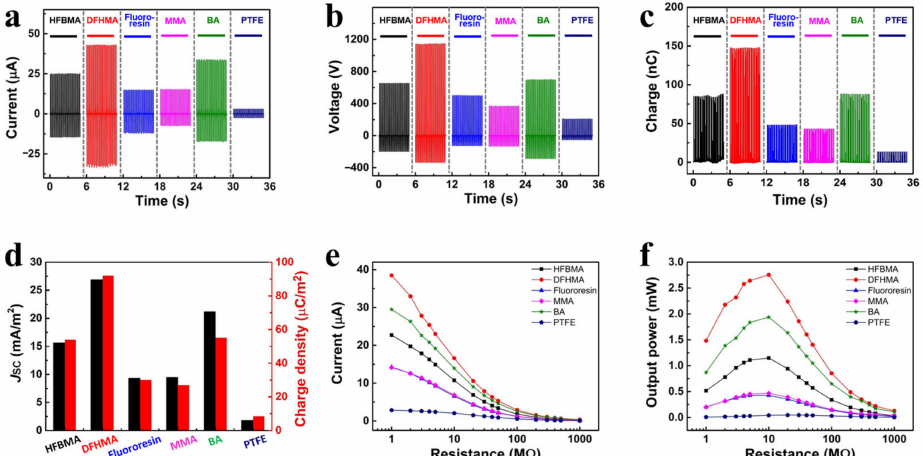
Figure 3. The output performance of the TENGs based on triboelectric coatings with different formulations and the commercial PTFE film: ( a ) short circuit current, ( b ) open circuit voltage, ( c ) transferred charge, ( d ) comparison by the bar plot of the current density and charge density. Current ( e ) and output power ( f ) of all TENGs with the different load